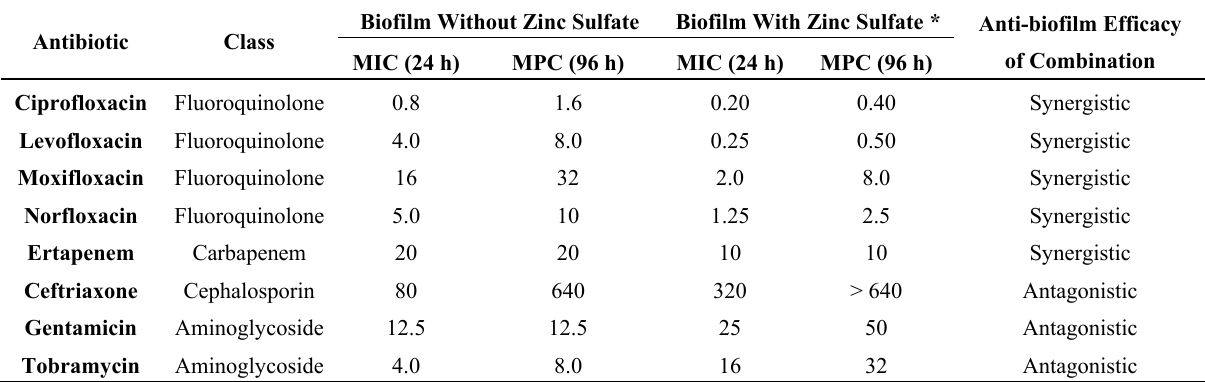
Tobramycin Aminoglycoside 4.0 8.0 16 32 Antagonistic * Zinc sulfate concentration (2.5 mM); MIC = Minimum Inhibitory Concentration; MPC = Mutant Prevention